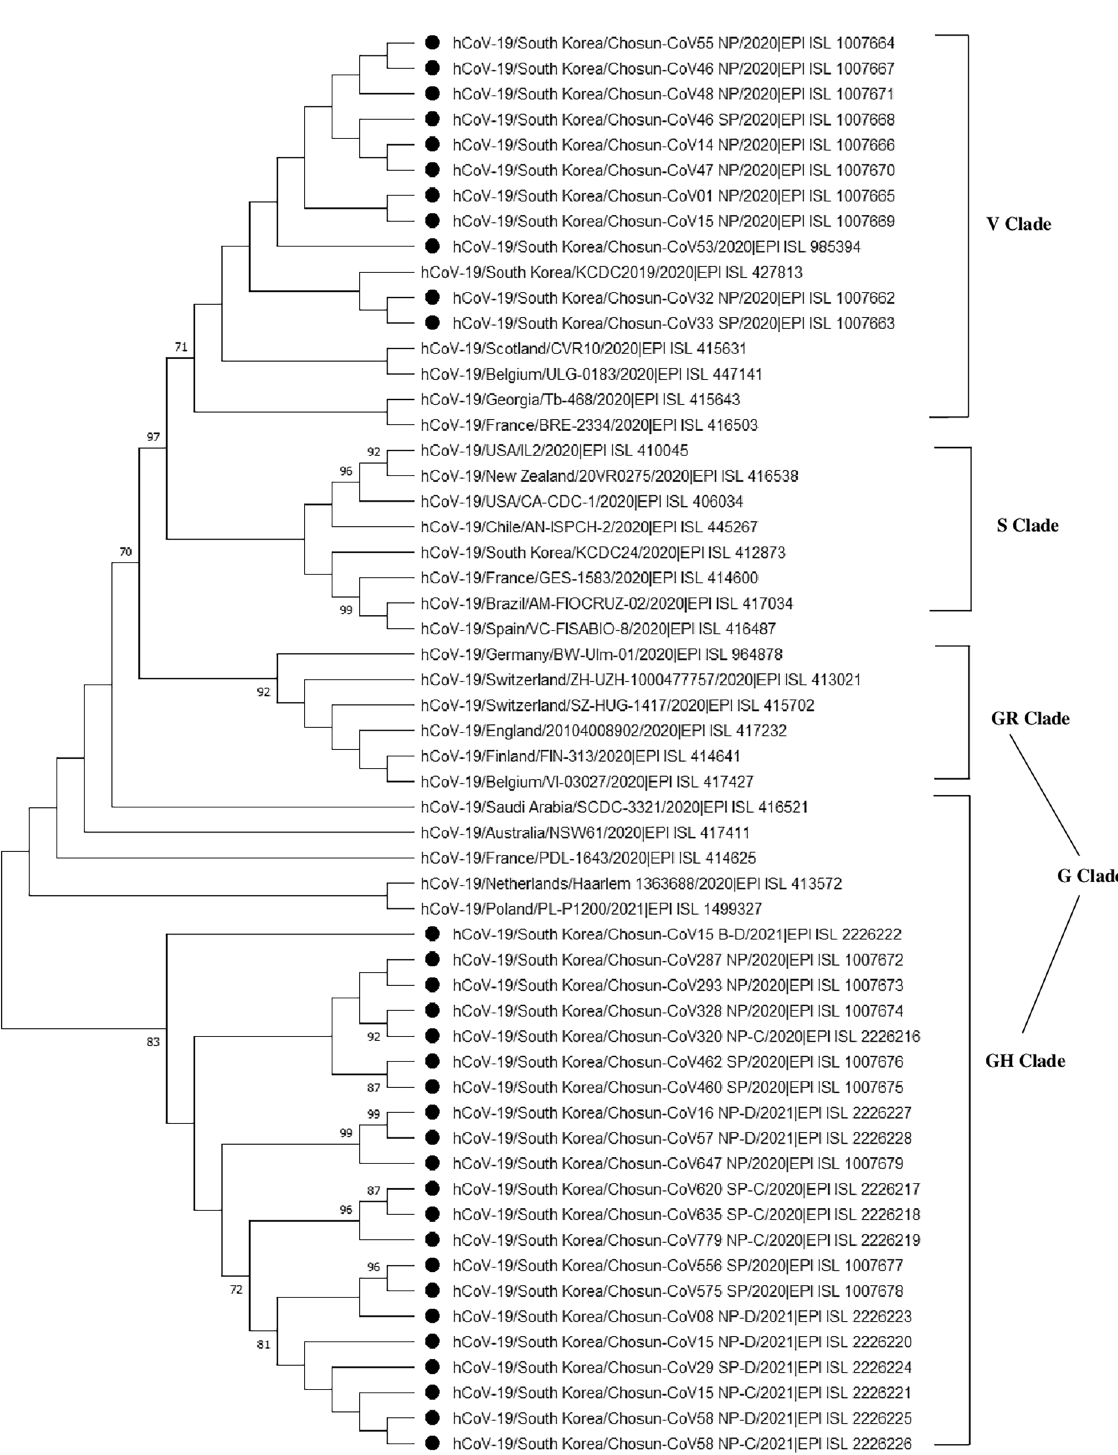
Figure 1. Phylogenetic analysis of complete/near complete genomes of the severe acute respiratory syndrome coronavirus 2 (SARS-COV-2) isolates. The evolutionary tree was constructed by the Maximum Likelihood (M-L) method using MEGA X software. The tree is drawn to scale, with branch lengths reflecting the number of substitutions per site (indicated below the branches). Only bootstraps greater than 70 are shown. To evaluate replicated tree confidence, 1000 bootstrap replicates were performed. The evolutionary distances were computed using the Tamura-Nei method and have been presented in the units of number of base substitutions per site. This analysis involved 56 nucleotide sequences. Clades are indicated on the